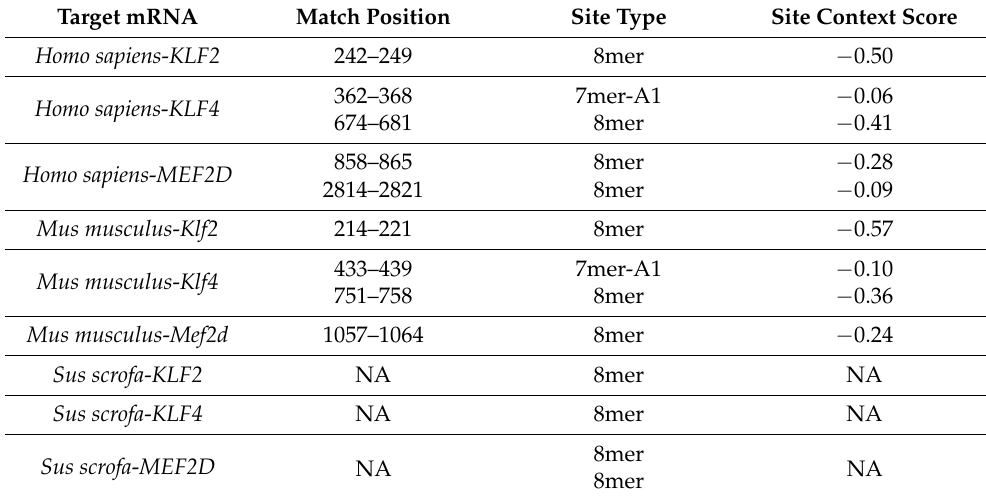
Table 1. In silico analysis results of miR-92a predicted downstream targets by